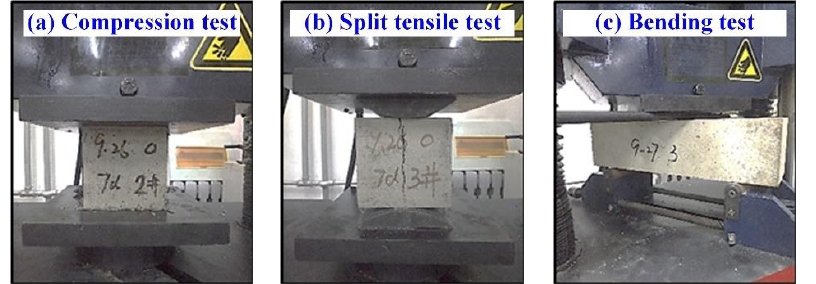
Figure 1. Basic mechanical properties test. .( a ) compression test; ( b ) split tensile test; ( c ) bending